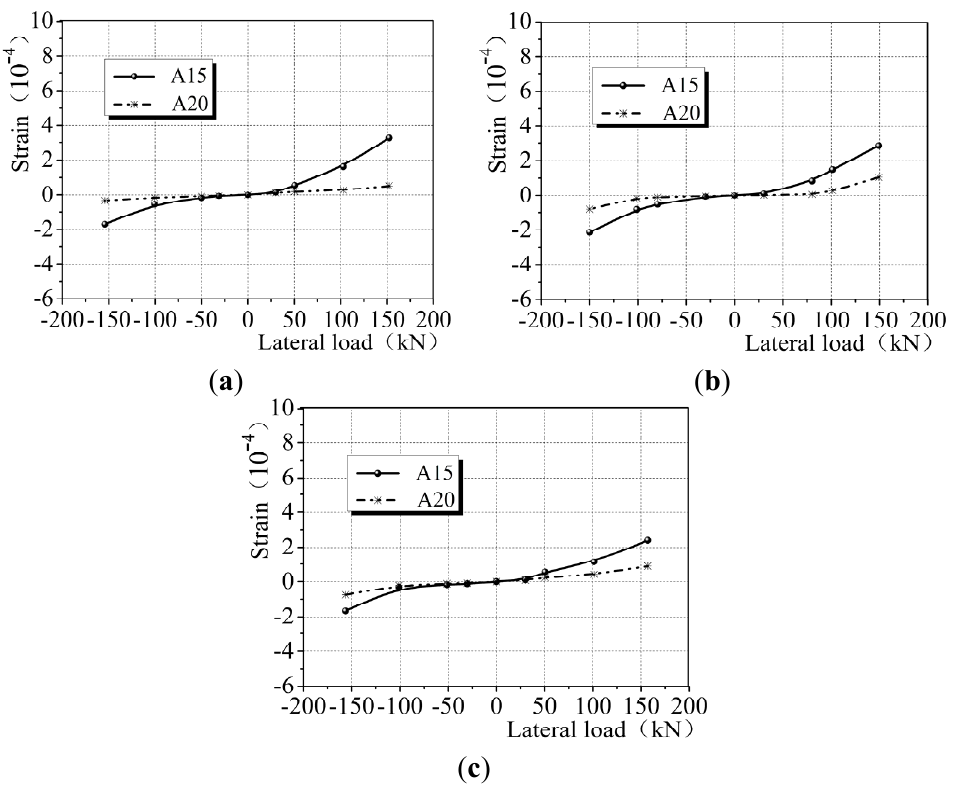
Figure 16. Lateral force-strain diagram in the front and at the back of CEW. ( a ) E-1; ( b ) E-2; ( c )